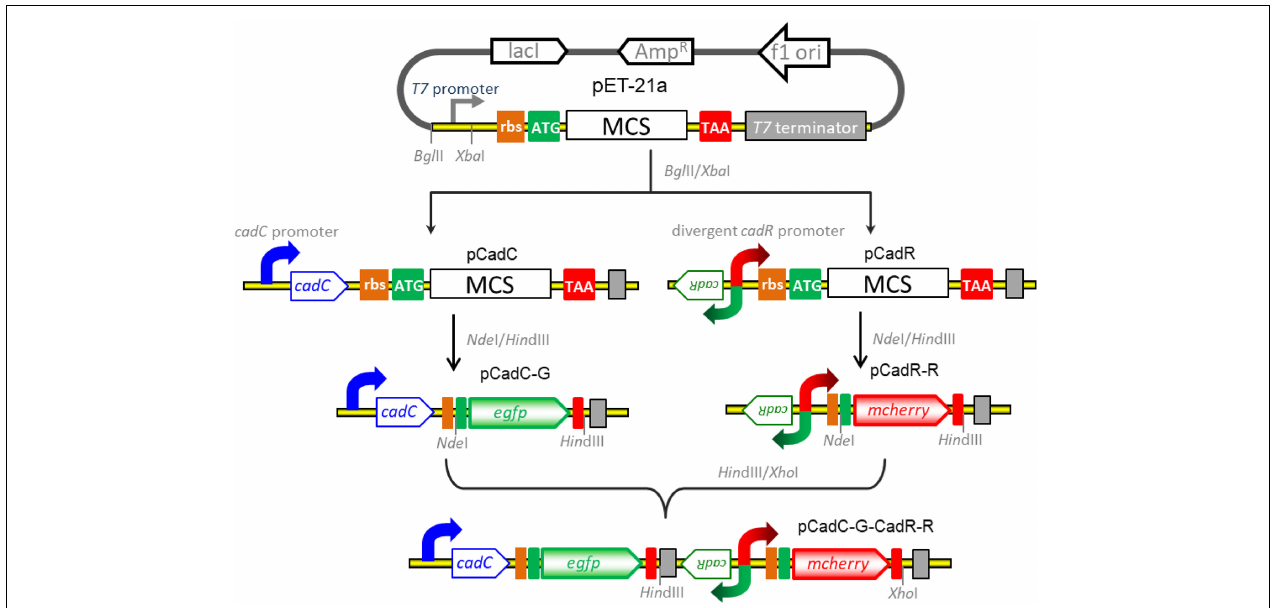
Frontiers in Microbiology |